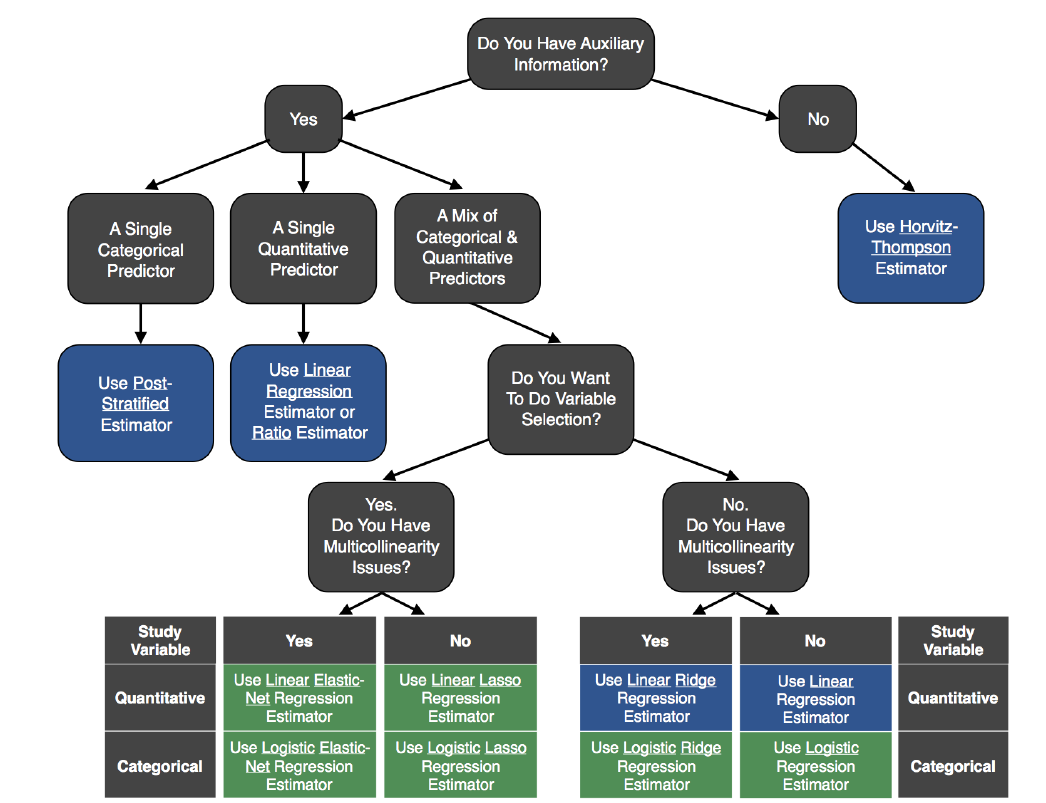
Figure 9. Flowchart of estimation options for the model-assisted parametric generalized regression estimators. Black boxes indicate splitting rules in the tree, while colored boxes indicate the recommended estimator. Estimators colored in blue are suitable for generic inference, while those colored in green can only be used for specific inference. Note that ratio estimators are used only where regression through the origin is